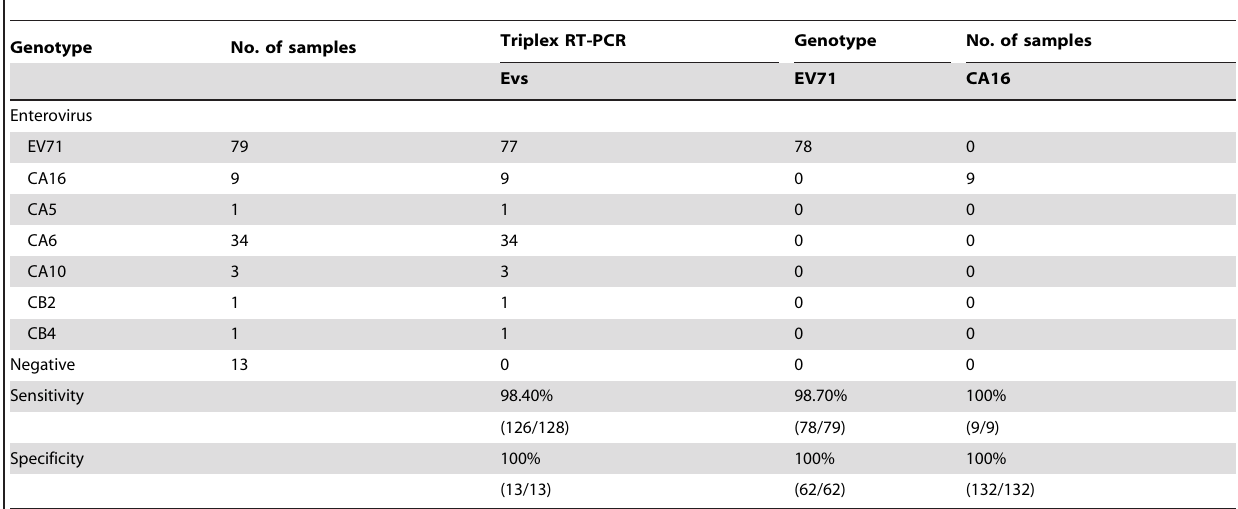
Table 3. The triplex RT-PCR results for clinical samples from HFMD